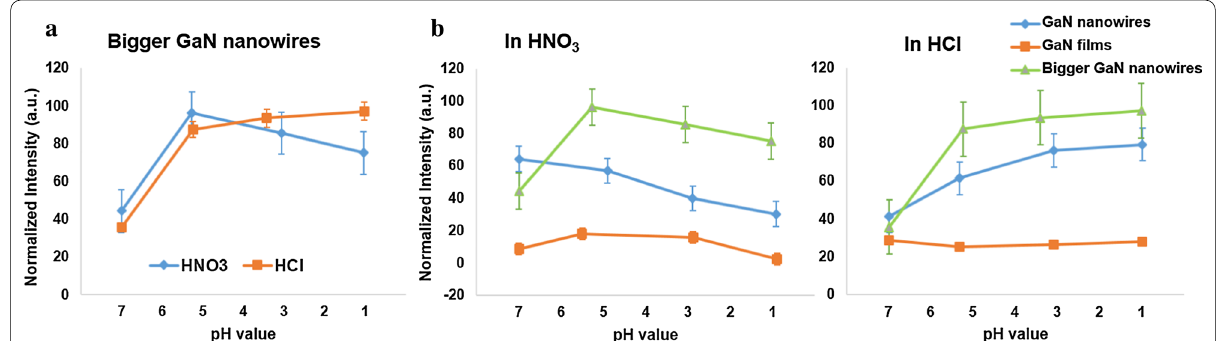
Fig. 3 Comparison of PL intensity from different sizes and dimensions of GaN. a The PL intensity distribution in various pH values of acidic solutions on bigger GaN nanowires with diameters of ~ 200 nm. b A comparison of PL intensity for GaN nanowires, GaN films and bigger GaN nanowires in HNO 3 and